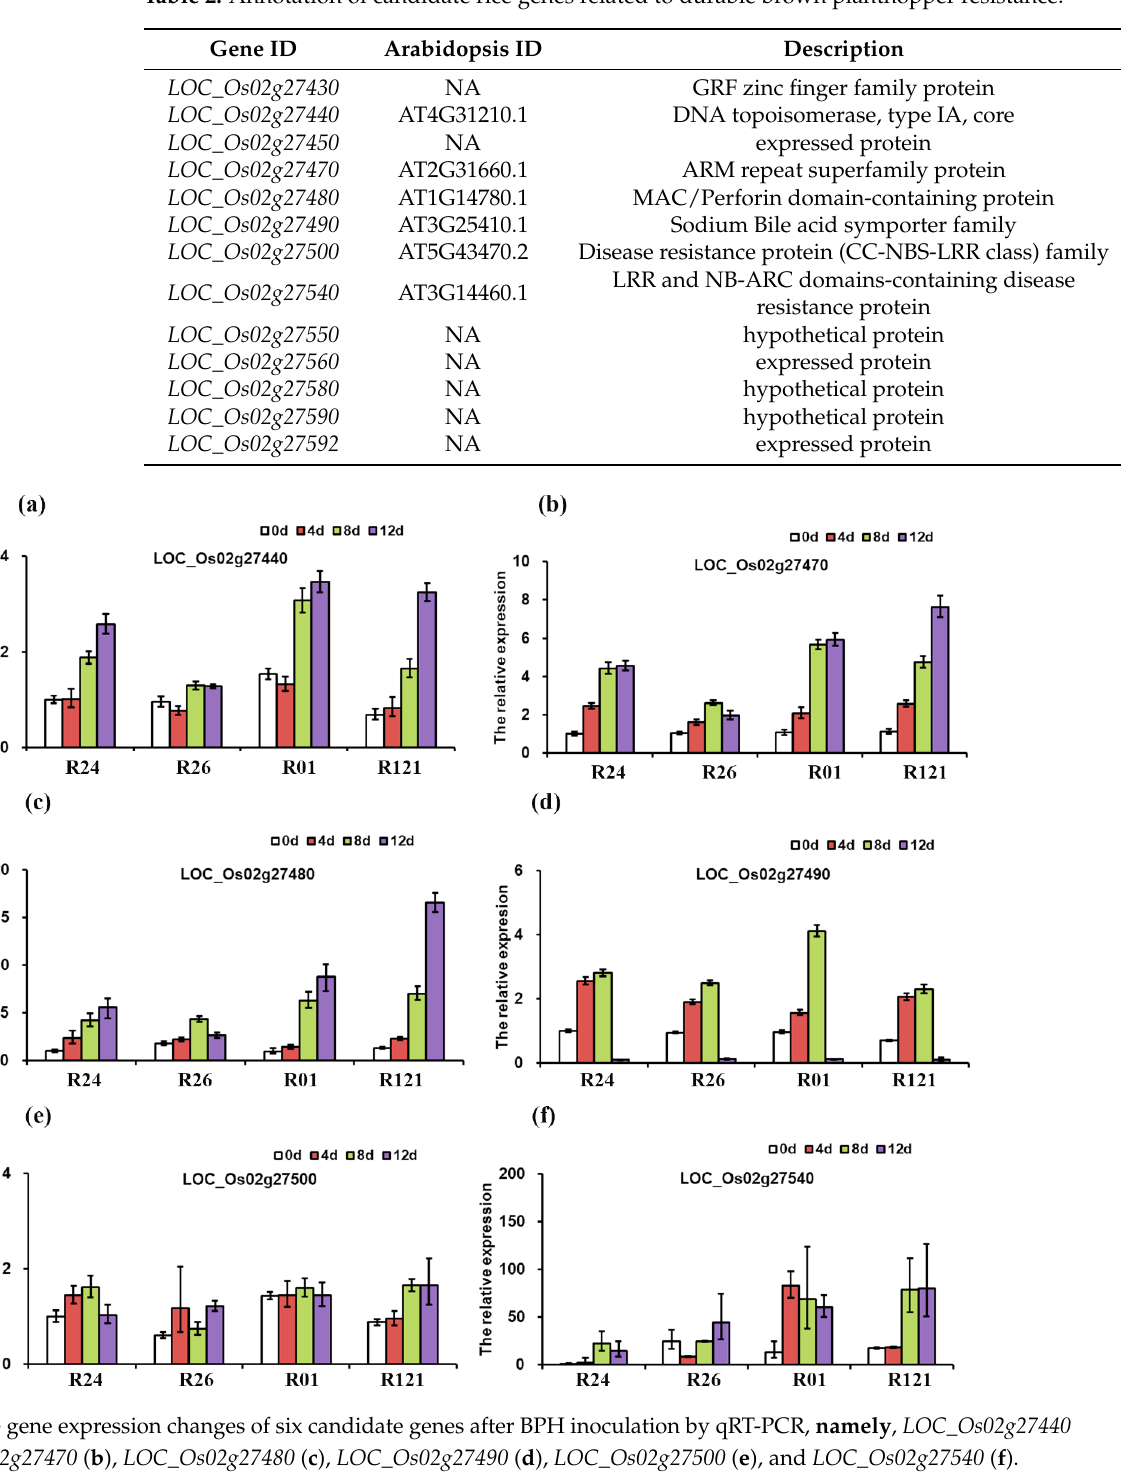
Table 2. Annotation of candidate rice genes related to durable brown planthopper resistance.